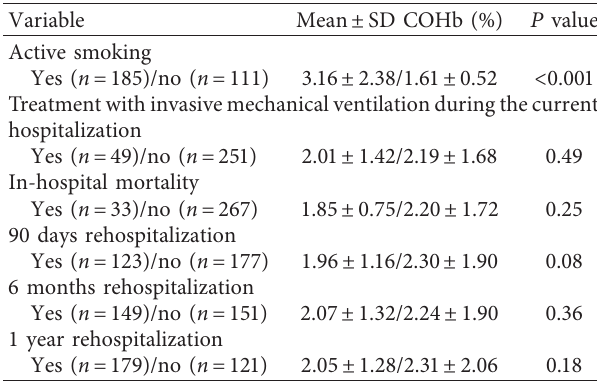
Table 2: Association of COHb levels with smoking and